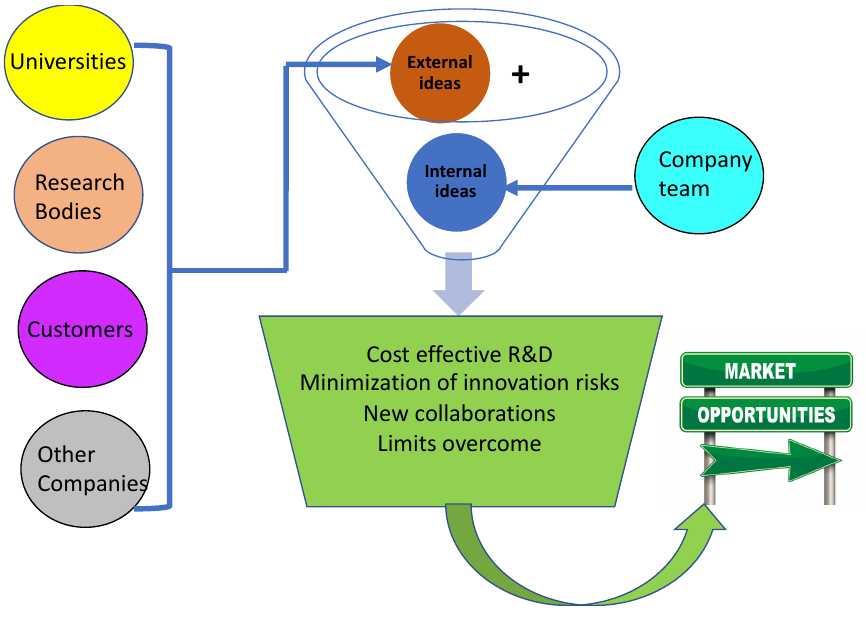
Figure 1. The open innovation concept.